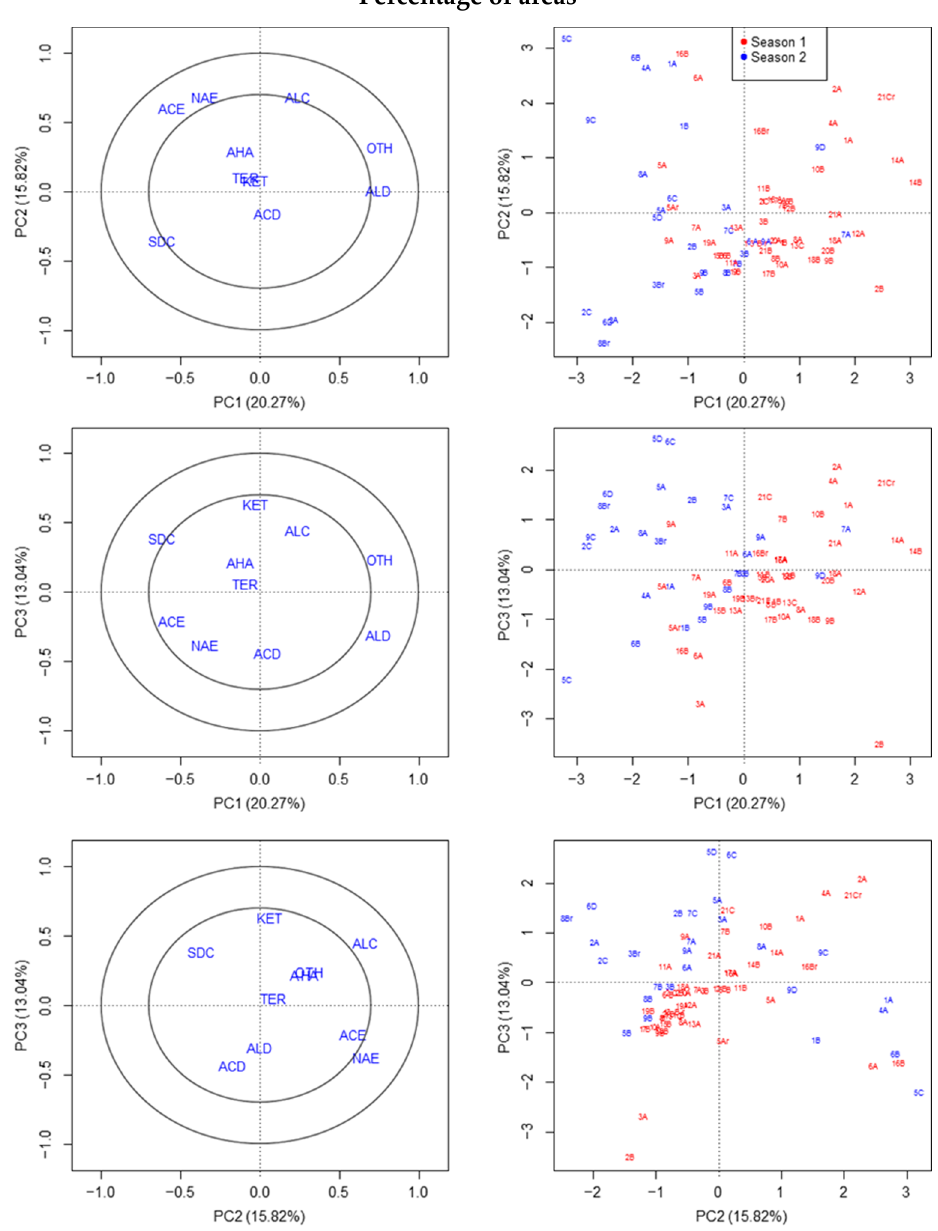
Figure 5. Correlation ( left ) and score ( right ) plots of the first three components of the PCA (with 49.13% of explained variance) applied to variables of different volatile organic compound classes based on percentages of total areas (only compounds with match quality >50) and without exogenous compounds included, obtained in two seasons, after removing the two fruit with outliers of season 1. ACE, acetate ester; NAE, non-acetate ester; ALD, aldehyde; ALC, alcohols, KET, ketones; SDC, sulfur derived-compounds; TER, terpenes; AHA, alkanes and aliphatic compounds; OTH, other compounds. Circles represent r 2 = 50% and 100% variability explained by the components.